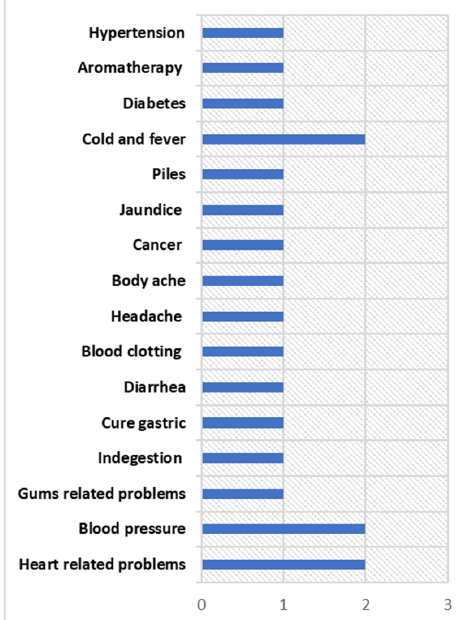
Figure 5. Common diseases neutralized using medicinal plants by the Monpas of Arunachal Pr